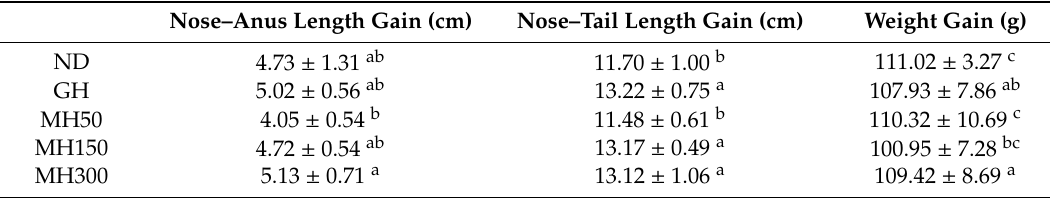
Table 1. The effect of dietary administration of a mixture of H. japonicus (MH) on nose-anus length gain, nose-tail length gain, and weight gain in SD rats. Table 1. The e ff ect of dietary administration of a mixture of H. japonicus (MH) on nose–anus length gain, nose–tail length gain, and weight gain in Sprague Dawley (SD) rats.